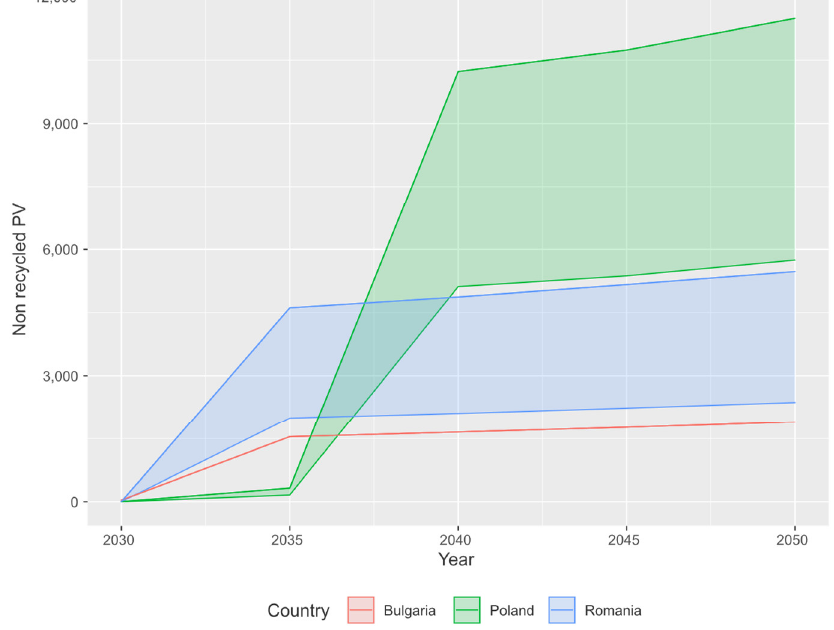
Figure 8. Prediction of non-recycled panels (area in thousand m 2 )—cumulatively in the years 2030–2050.